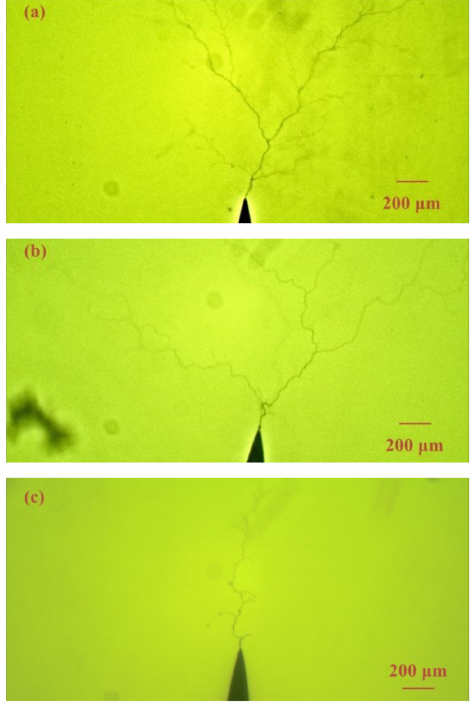
Figure 3. Electrical tree morphology in epoxy casting insulation samples without air gap under 8 kV bipolar square-wave voltage with frequency of ( a ) 1 kHz, ( b ) 8 kHz, ( c ) 20 kHz.